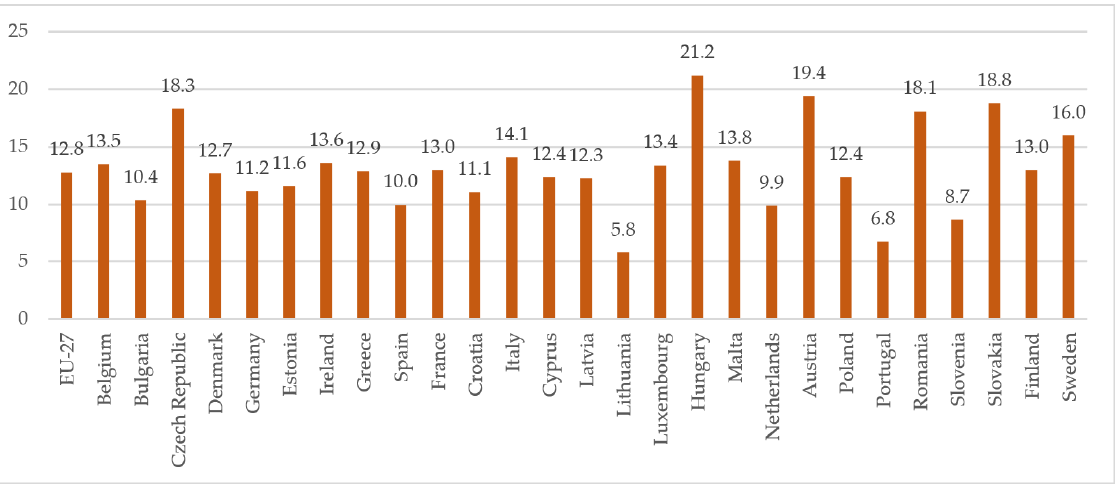
Figure 7. Share of buses and trains in inland passenger transport in EU countries in 2020, %. Source: [74].